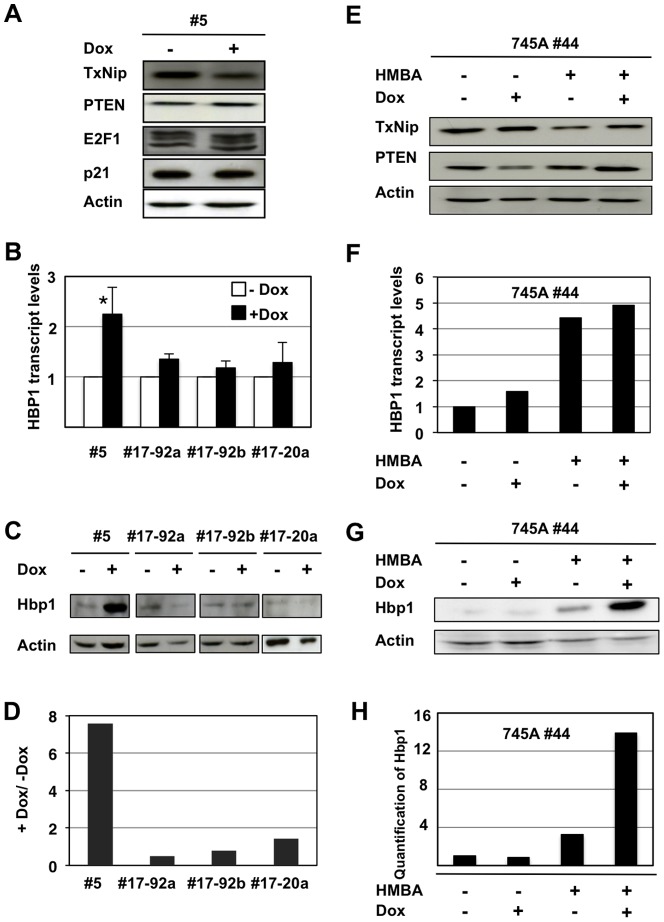
miR-17 and miR-20a contribute to Hbp1 regulation in NN10#5 and 7451#44 cells.A, B, C and D : Parental NN10#5 cells and their derivative #17-92a, #17-92b and #17-20 were cultured for two days in the presence or absence of Dox before Western blot and qRT-PCR analyses of known targets of miR-17-92 cluster. A: Western blot analysis of non-regulated targets in NN10#5 cells. B: Histograms show relative levels of hbp1 mRNA in the indicated Dox-treated cells normalized to that in untreated cells (means and standard deviations from 3 experiments). Asterisks indicate significant differences induced by Dox treatment (p<0.05). C: Western blot analysis of Hbp1 protein. D: Quantification of Hbp1 protein level variations in response to Dox between the indicated cells (+Dox/-Dox ratios of Hbp1 signal standardized to Actin signal determined by densitometric analysis of Western blot shown in C). E, F, G and H : 745#44 cells were grown as in Figure 1 for two days in the presence or absence of HMBA or Dox as indicated. E: Western blot analysis of non-regulated targets. F: Histograms show relative levels of hbp1 mRNA (typical results from two different experiments). G: Western blot analysis of Hbp1 protein (typical results from two different experiments). H: Quantification of relative levels of Hbp1 protein standardized to actin.